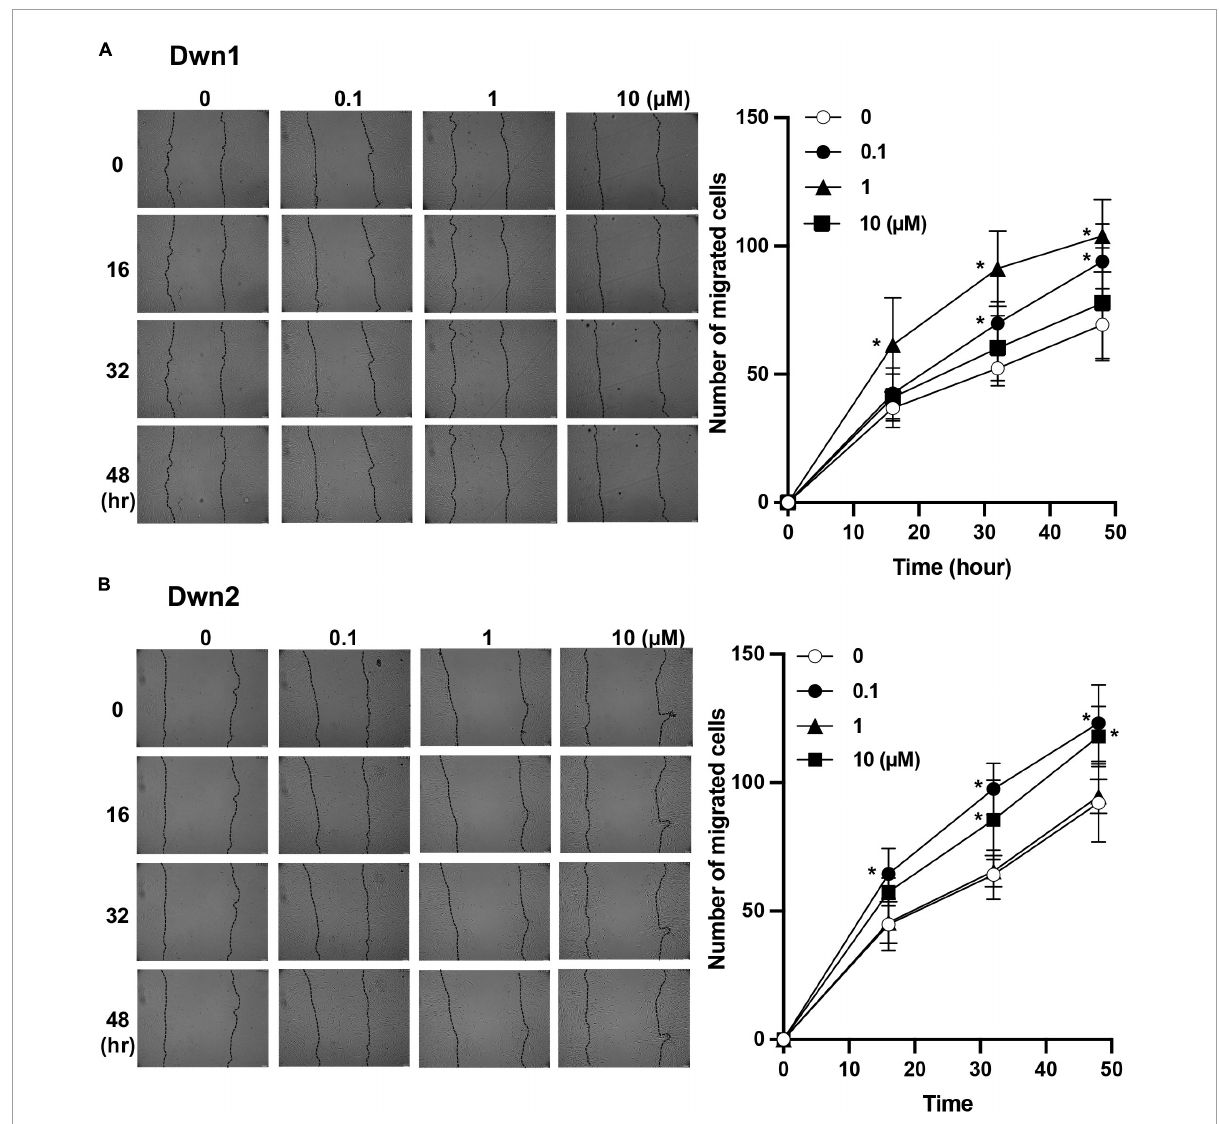
FIGURE3 Cell migratory assay. (A) The number of migratory cells was recorded throughout 48-h treatment for both control (0 µ M) and Dwn1 treated groups. The lefthand image shows images of scratch test site with cell infiltration used to generate graph. The average number of Dwn1 treated cells indicated significantly higher cell migration beyond the scratch test border for all time points in the 0.1 and 1 µ M treatment groups. (B) The number of migratory cells was recorded throughout 48-h treatment for both control and Dwn2 (0 µ M) treated groups. The lefthand image shows images of scratch test site with cell infiltration used to generate graph. The average number of Dwn2 treated cells indicated significantly higher cell migration beyond the scratch test border for all time points in the 0.1 and 10 µ M treatment groups ( N = 6). The p -value was calculated between these groups (* p < 0.05). Graphs represent the average ±